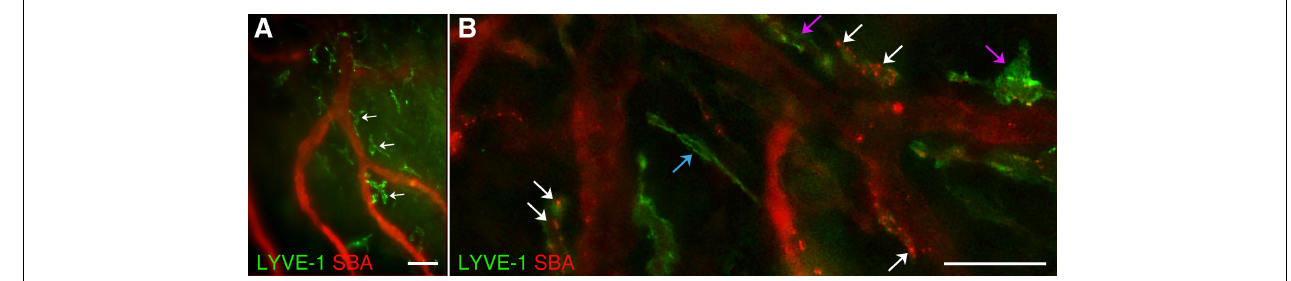
FIGURE 5 | LYVE-1 positive macrophage-like structures. In wild type C57BL/6J mice, blood vasculature and lymphatics were visualized by AlexaFluor 594-conjugated SBA lectin and AlexaFluor 488-conjugated anti-mouse Lyve-1 antibody, respectively. (A) Numerous LYVE-1 positive blood vessel-associated macrophage-like structures (green, white arrows) were found throughout the dura connective tissue stroma. (B) LYVE-1 positive structures (green) appearing as individual vessels (blue arrow) or macrophage-like structures closely associated with blood vessels (purple arrows) including LYVE-1 positive areas with SBA staining on their walls (white arrows) are observed. In (A,B) LYVE-1 staining (green) and SBA lectin staining (red). Scale bars 50 µ m.